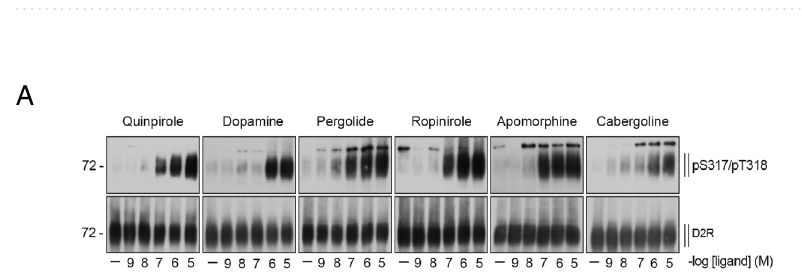
Table 2. Potency (pEC 50 ) and maximal effect (E max ) estimates for agonists activating D 2 R regulatory pathways. Concentration–response curves from Figs. 3 and 4 were analyzed using a three-parameter fit (Eq. 1). Values represent the mean ± SEM. ND Not determined: unable to be determined due to insufficient response to allow accurate fitting of the model.